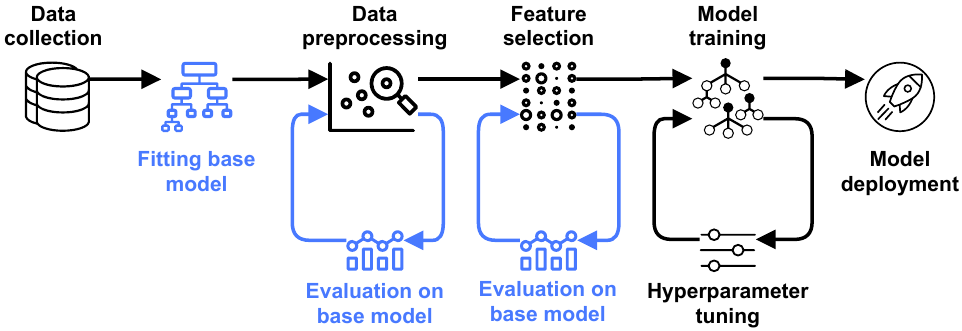
Figure 6. The pipeline of the proposed data-centric ML